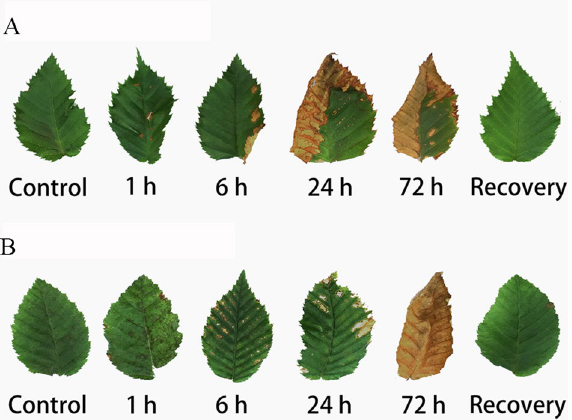
Figure 1. Leaf injury symptoms of Carpinus betulus ( A ) and Carpinus putoensis ( B ) under different NO 2 exposure time and after